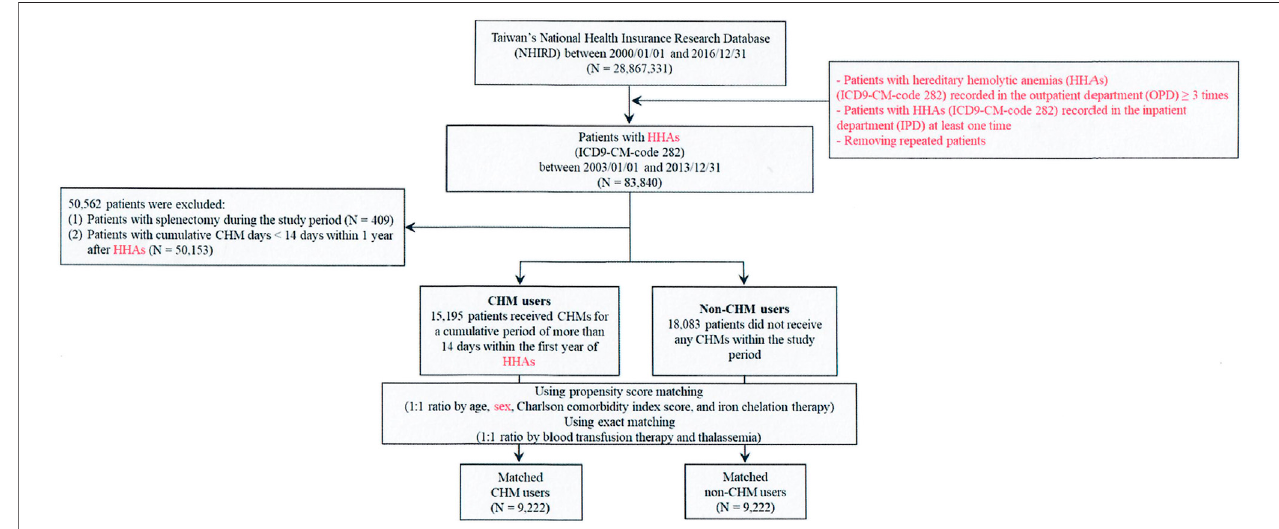
FIGURE 1 | Flowchart of hereditary hemolytic anemias patient enrollment.